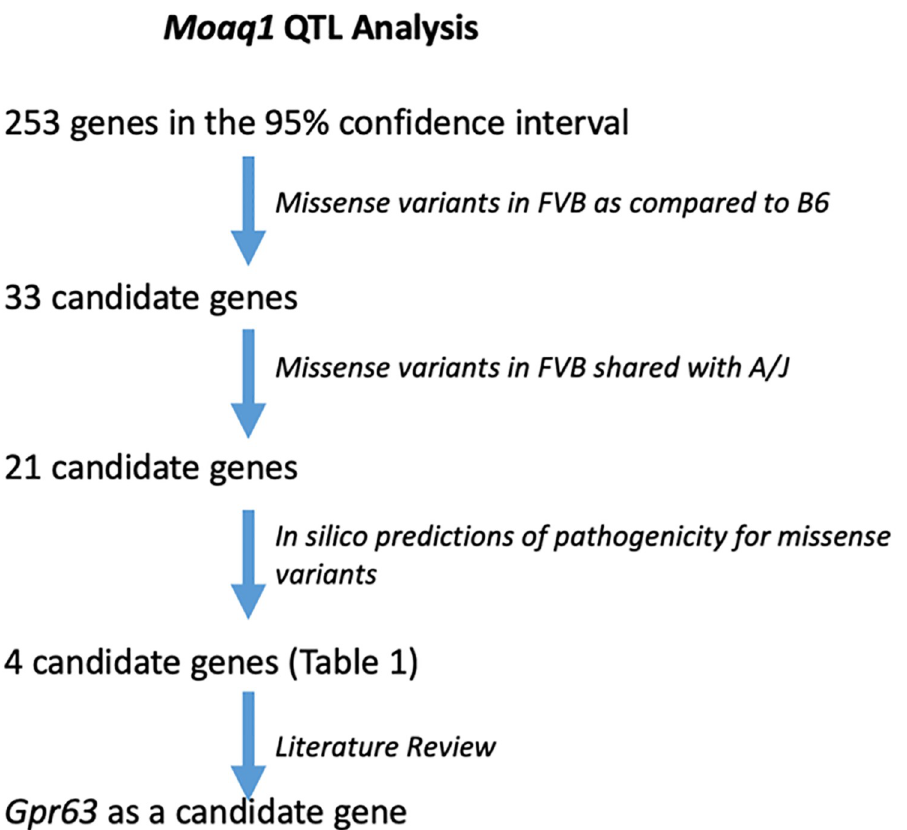
Fig 4. An outline of the analysis leading to the hypothesis Gpr63 is a causal gene in the Moaq1 interval.